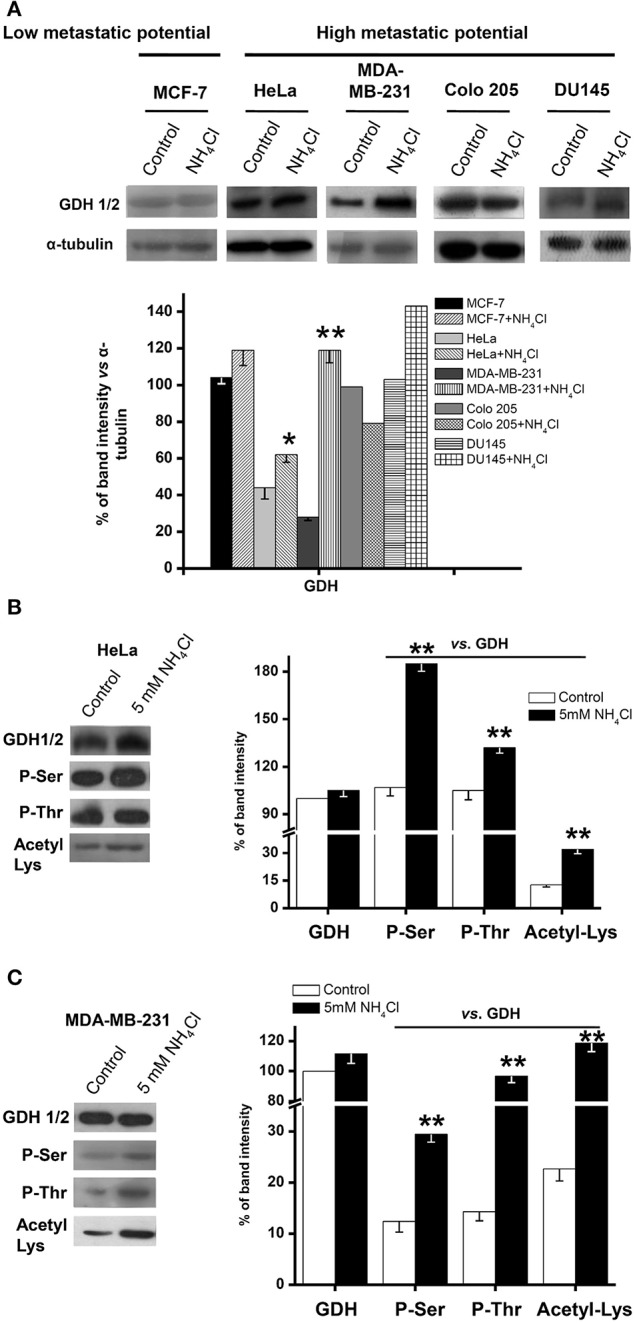
Glutamate dehydrogenase covalent modifications in human metastatic cancer cells. Total GDH protein content by Western blotting (A) and GDH phosphorylation and acetylation status by immunoprecipitation (B,C) were determined, as described in Materials and Methods, in MCF-7, HeLa, MDA-MB-231, Colo 205, and DU145 cells exposed to 5 mM NH4Cl (except for DU145, which was exposed to 1 mM) for 5 days in 2-D cultures. Representative results are shown. α-Tubulin was used as loading control and for data normalization in the Western blot experiments (A); the control GDH protein signal of each individual experiment (no NH4+ added) was used for initial normalization of the GDH signal with NH4+ in the immunoprecipitation assays (B,C), followed by comparison of the phosphorylation and acetylation signals against their respective total immunoprecipitated GDH (control or 5 mM NH4Cl) signal. Densitometric analysis represents the mean ± SD of three independent cell cultures (except for Colo 205 and DU145, n = 2). Statistical analysis was performed using one-way ANOVA with Scheffé comparison test. *P < 0.05, **P < 0.01 vs. control.